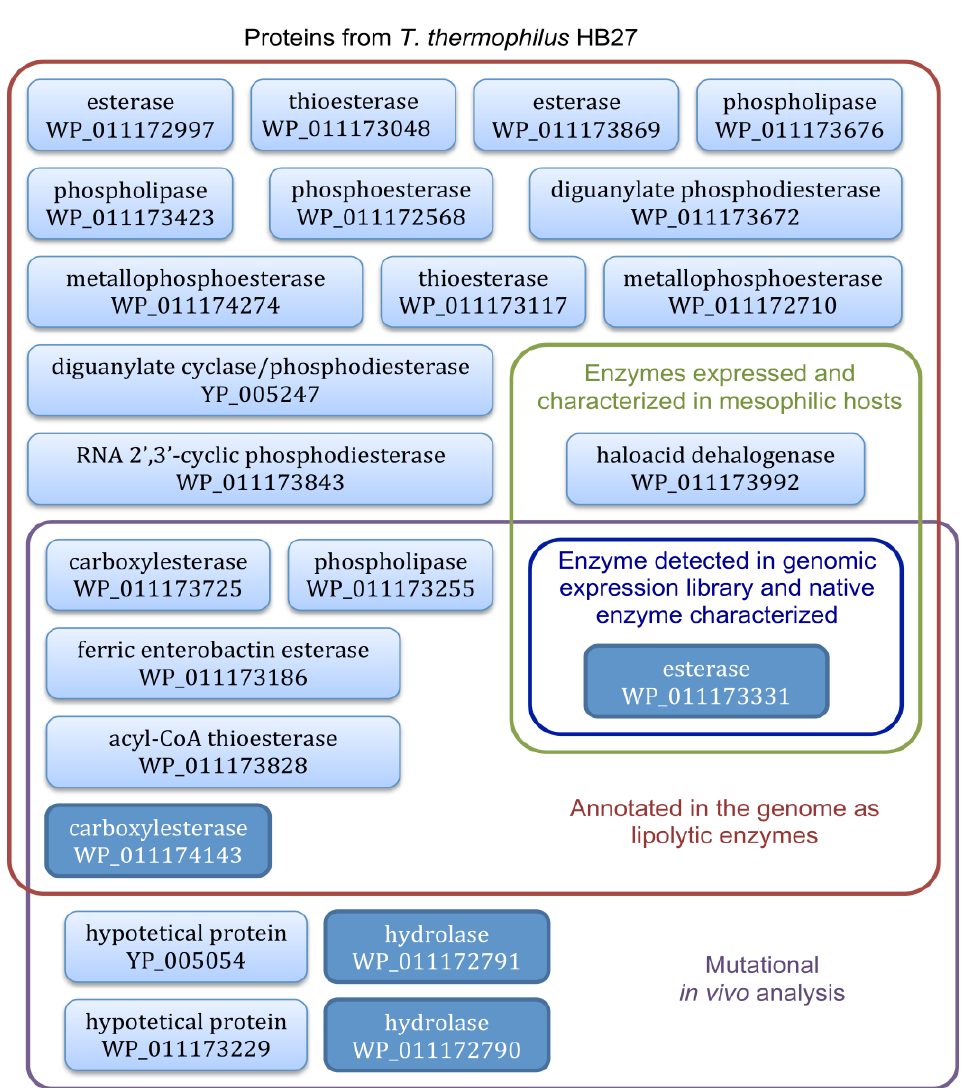
Figure 4. Scheme of predicted proteins from T. thermophilus HB27 (genome reference NC005835) studied hitherto to analyze its lipolytic activity and type of assay used. Boxes in dark blue correspond to the proteins identified to be mainly responsible for the lipolytic activity in T. thermophilus HB27. Boxes using former nomenclature (YP 005247 and YP 005054, genome reference AE017221) correspond to records that have been removed after the recent genome annotations